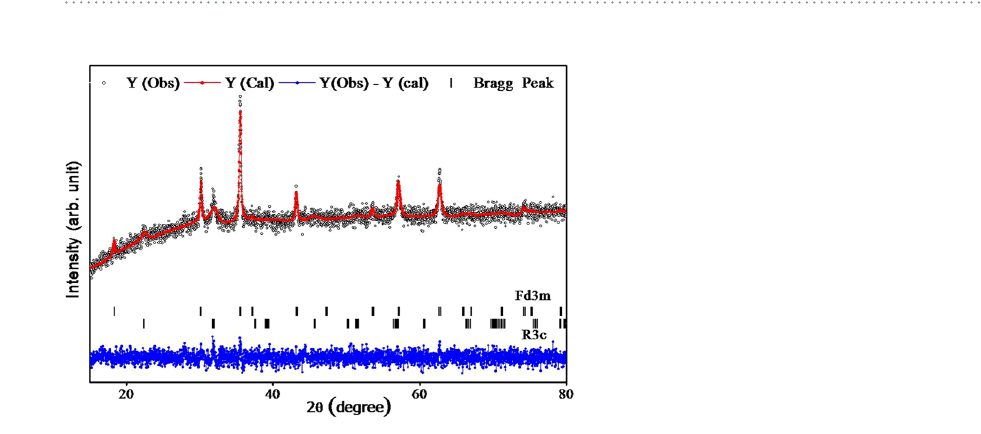
Figure 1. Powder XRD patterns of CBF for x = 0.0, 0.05, 0.10, 0.15 and 0.20. Inset is the (311) peak positions of CoFe 2 O 4 for various Bi 3 + -doping levels i.e. various x values.